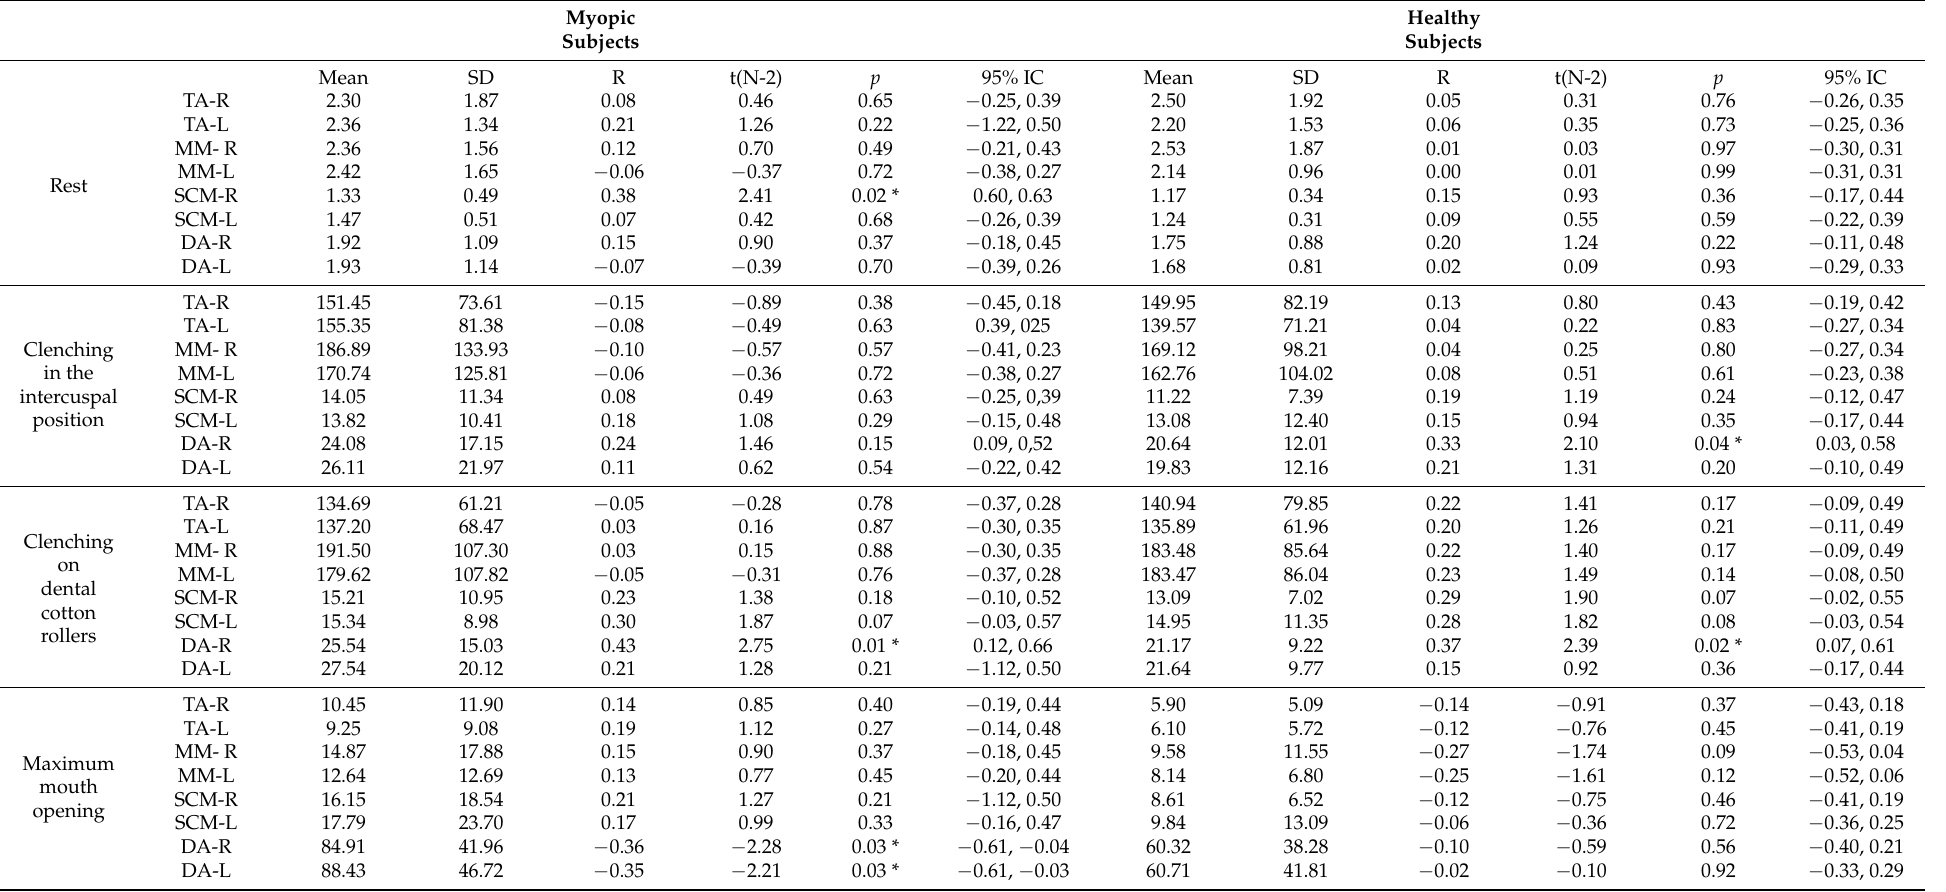
Table 3. Summary of myopic subjects’ and healthy subjects’ results of the open eye